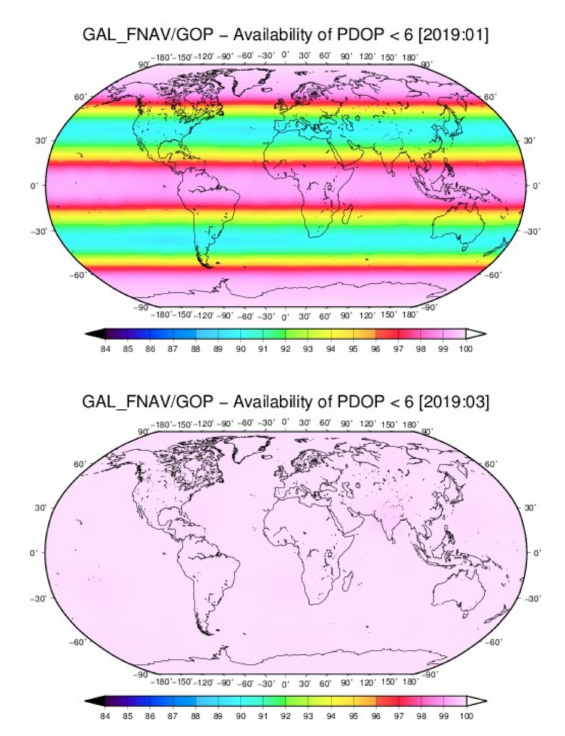
Figure 2. Availability of the Galileo Position Dilution Of Precision (PDOP) < 6 in January (left) and March (right),